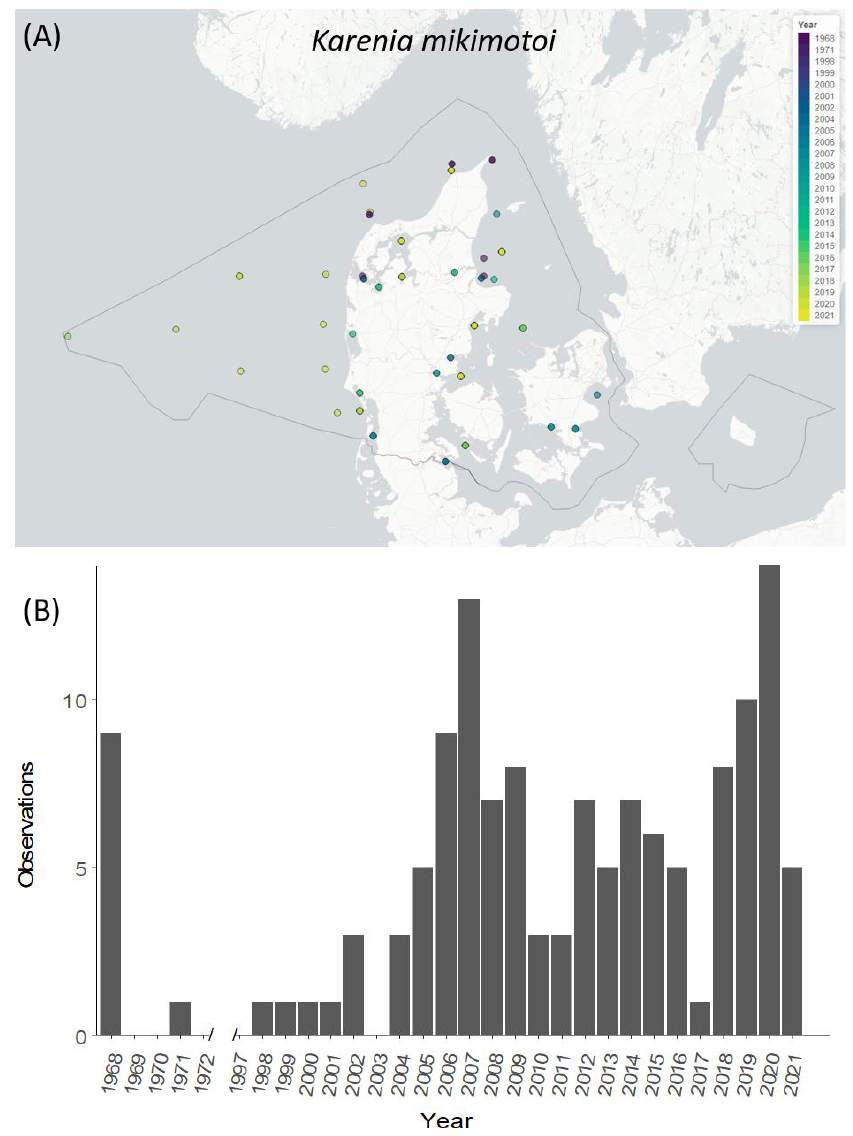
Figure 9. Karenia mikimotoi . ( A ) Map of sampling stations with known occurrences since 1998 within the Danish EEZ; ( B ) number of annual observations. Data from 1998 were obtained from the Danish National Monitoring Program (NOVANA) (Supplementary Table S2). Data from 1968 and 1971 from [99].